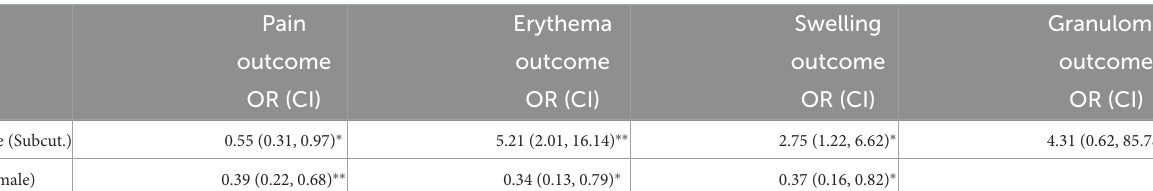
TABLE 4 OR coefficients and confidence intervals for qualitative predictor variables.